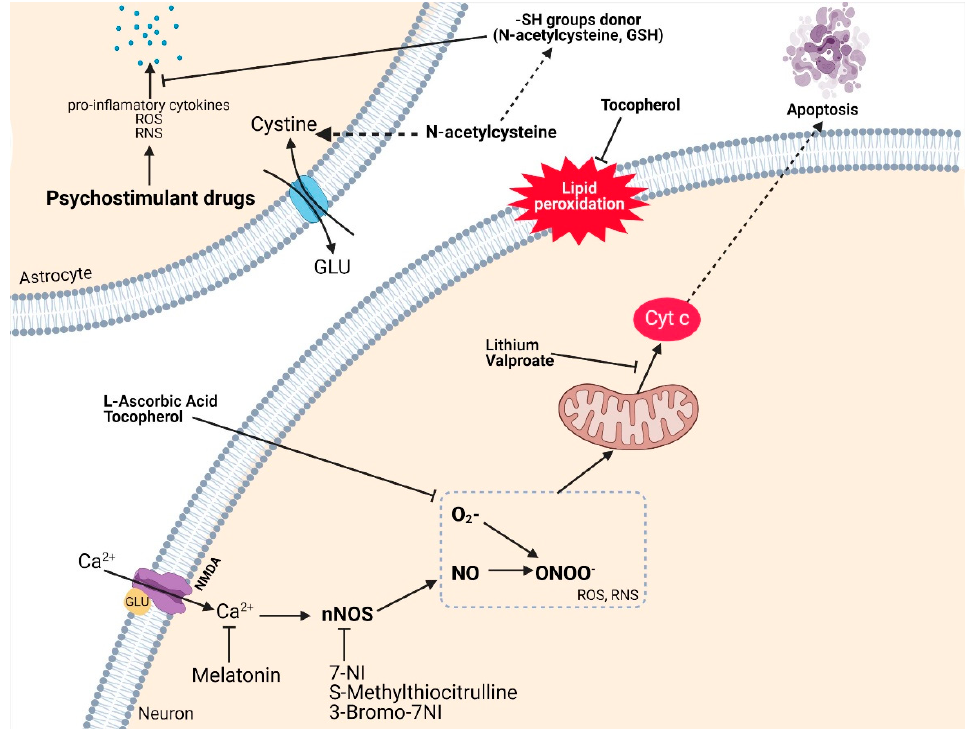
Figure 7. This illustration summarizes the proposed mechanism of antioxidant therapy in drug-related toxicity. Excessive stimulation of NMDA receptors by glutamate (GLU) generates numerous reactive oxygen (ROS) and/or nitrogen (RNS) species, subsequently leading to mitochondrial dysfunction, lipid peroxidation, and apoptosis. Thus, the use of compounds with antioxidant activity (e.g., L-ascorbic acid, tocopherol) reduces the oxidative status and preserves the integrity of the cell membrane. Lithium and valproic acid are involved in the correction of the malfunction of the mitochondrial membrane preventing the release of cytochrome c and reducing the expression of proteins involved in the apoptotic process. Neuronal nitric oxide synthase (nNOS) inhibitors limit the production of RNS. Melatonin protects against oxidative damage by regulating the intracellular level of Ca 2+ . N-acetylcysteine exerts its protective effect by regulating the level of GSH and controlling the concentration of GLU; following stimulation of the antiport cystine-glutamate and regulating the level of pro-inflammatory cytokines. Created with BioRender.com (accessed on 22 January